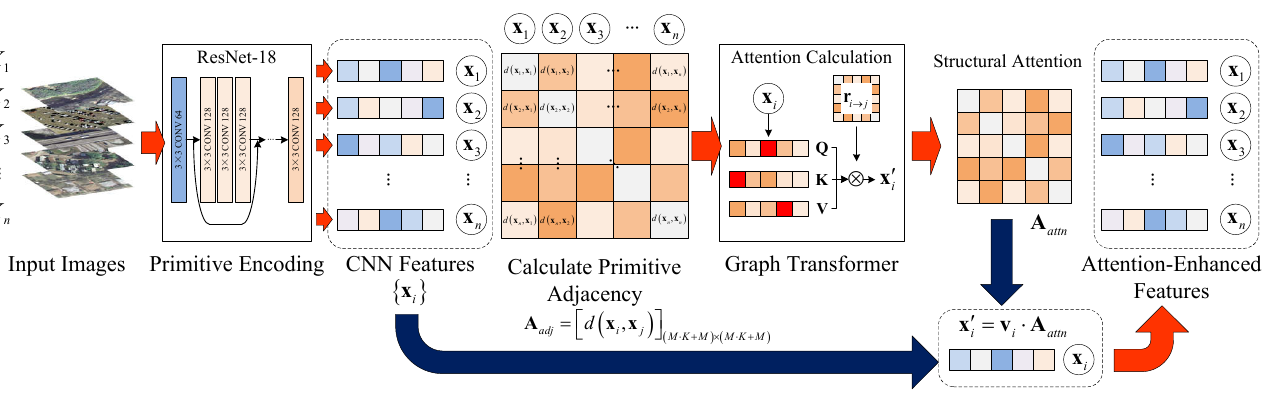
Figure 3. Illustration of the processing procedure of the encoding